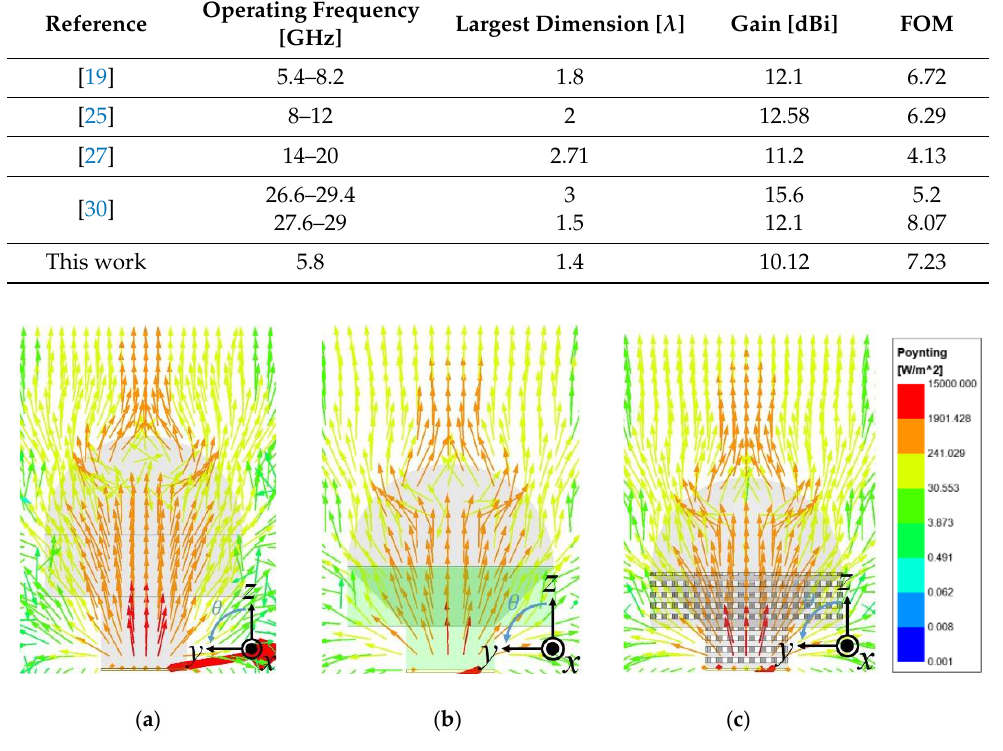
Figure 8. Poynting’s vector plot at 5.8 GHz. ( a ) Model 1. ( b ) Model 2. ( c ) Model 3. Table 1. Comparison table of the lens antenna. All the values are from the measurement. The wave- length for the dimension is calculated at the center